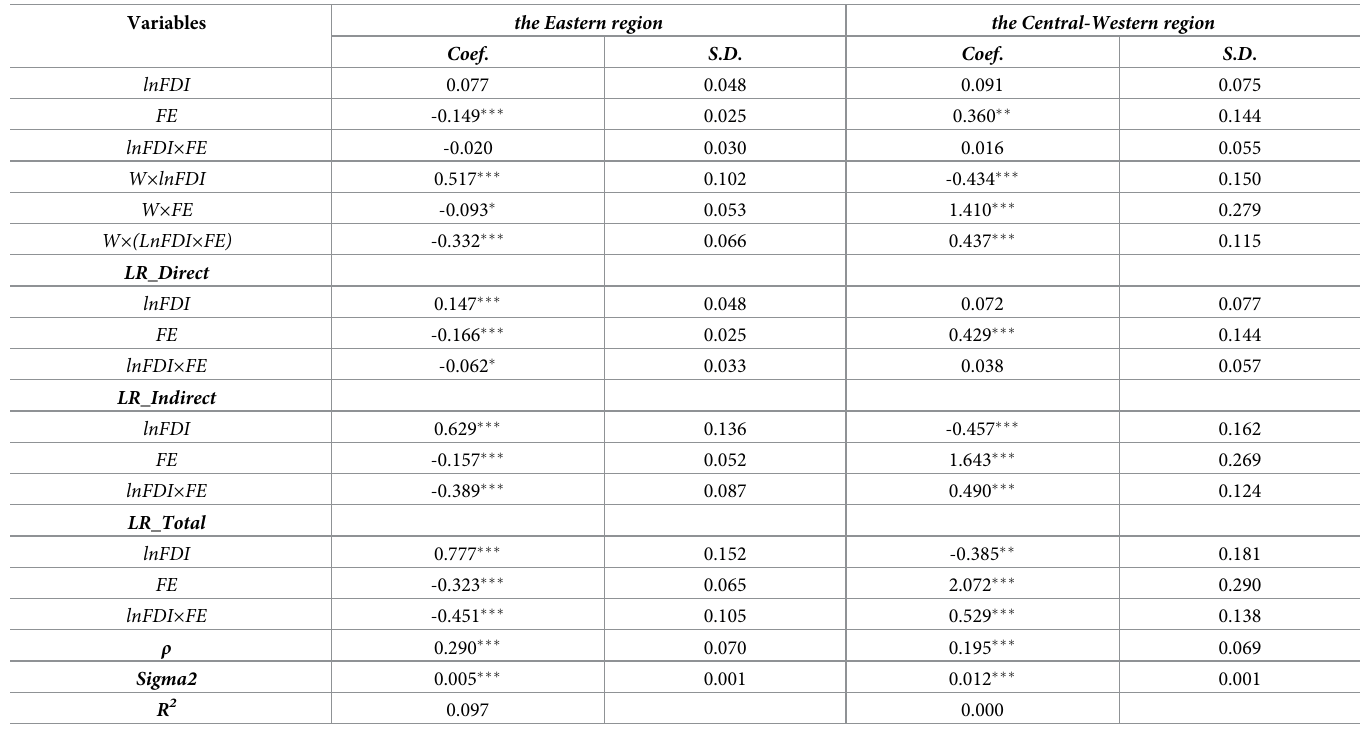
Table 9. The regression results of the Eastern region and the Central-Western region. Variables the Eastern region the Central-Western region Coef